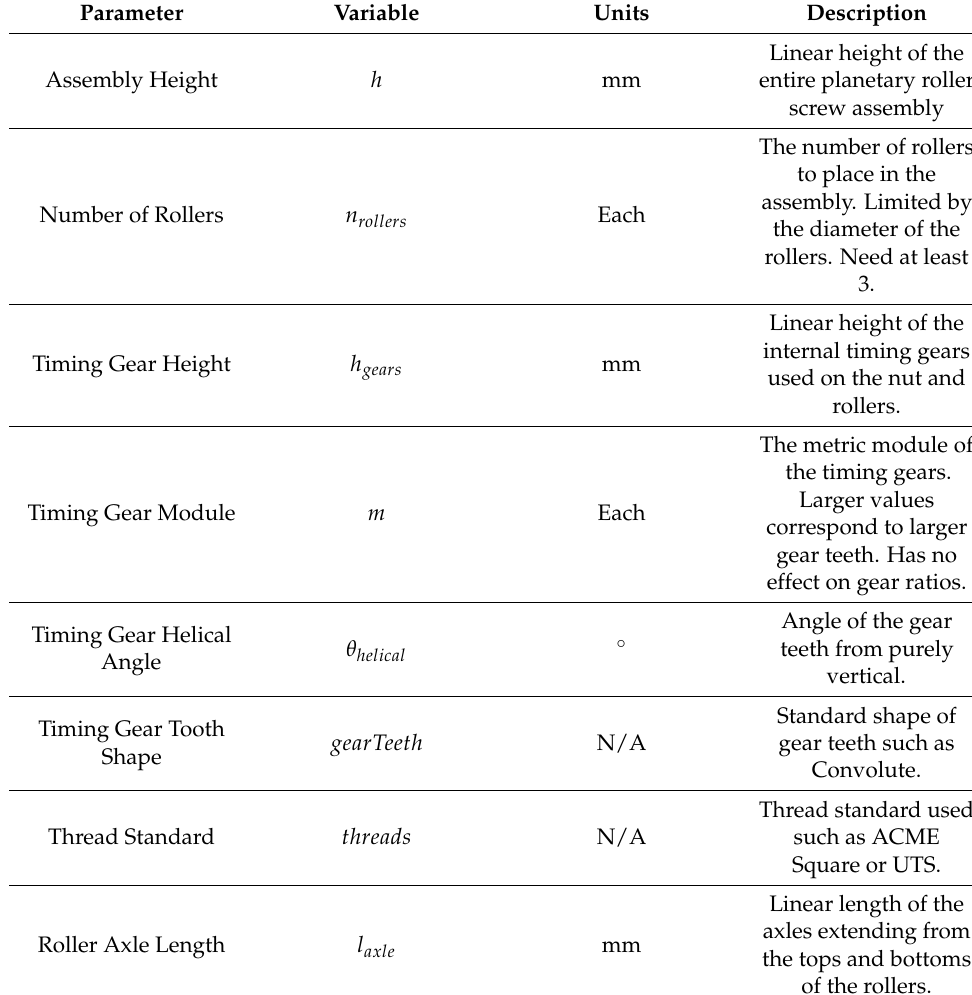
Table 3. Necessary mechanical parameters for constraining the planetary roller screw. Parameter